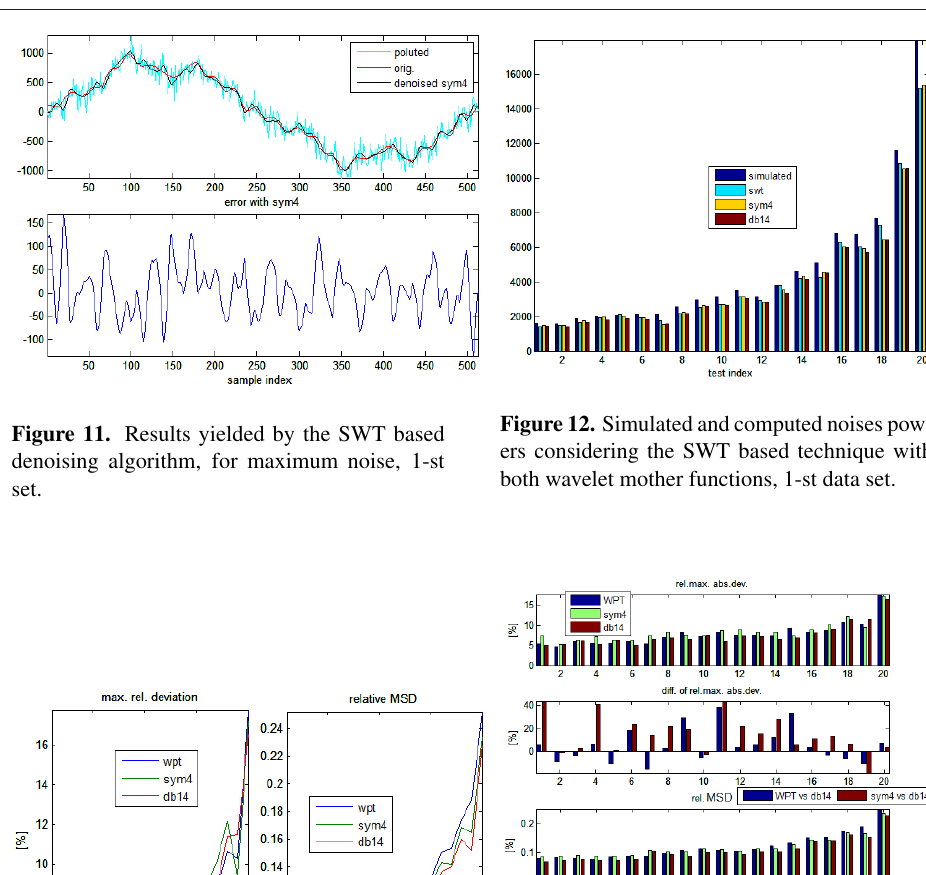
Figure 14. From top to bottom: relative maxim absolute deviations; relative percentage di ff erences (with db14 as reference) for relative maxim absolute deviations ; mean square rela- tive deviations; relative percentage di ff erences (with db14 as reference) for mean square rela- tive deviations. 1-st